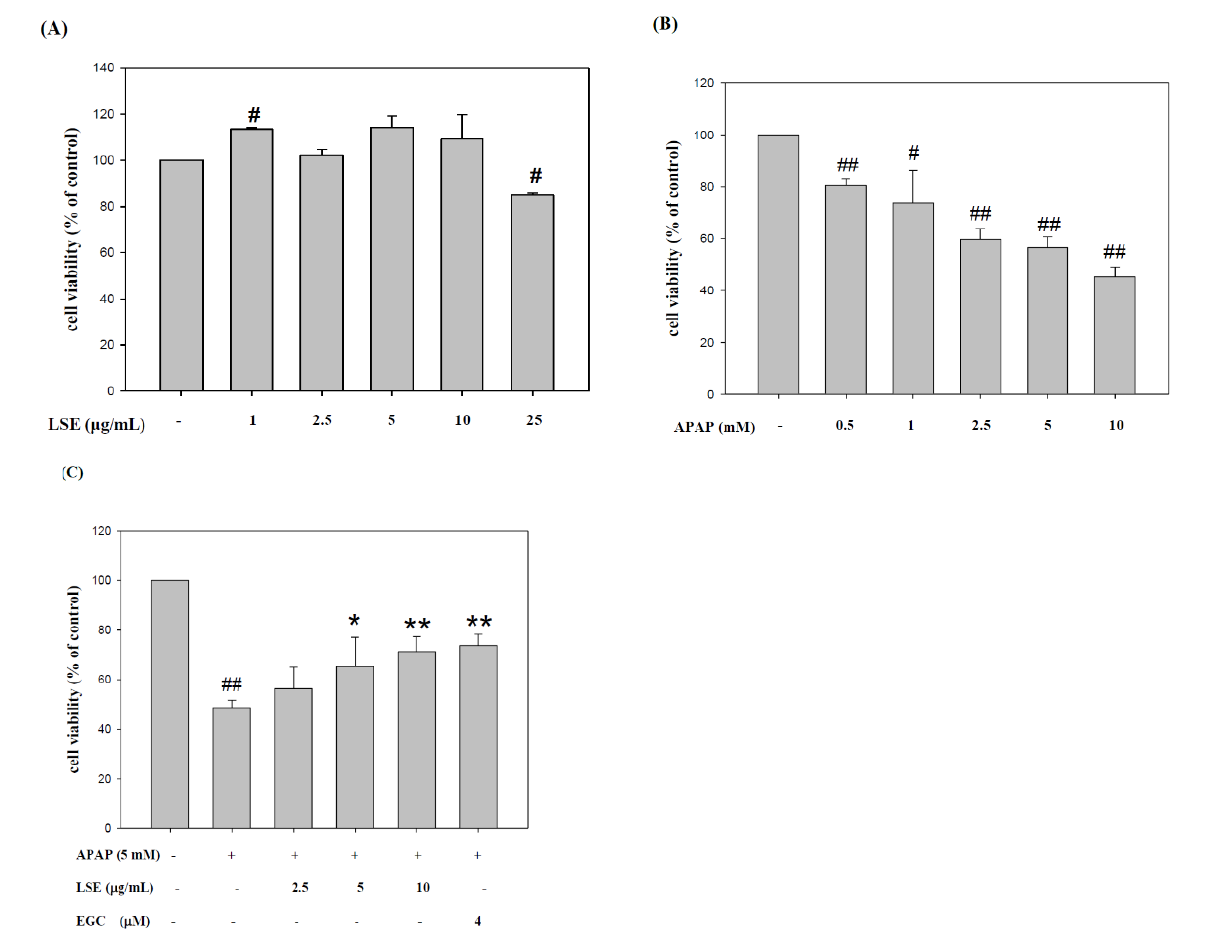
Figure 1. LSE or EGC co-treated with toxic dose of APAP elevated HepG2 cell survival rate. First, the cytotoxic effects of ( A ) LSE and ( B ) APAP in various concentrations on HepG2 cells were evaluated. ( C ) The HepG2 cell viability of APAP in 5 mM with/without LSE in 2.5, 5, and 10 µg/mL or 4 µM EGC. All data are presented as means ± SD of three independent experiments. # p < 0.05, ## p < 0.01 compared with the control group. * p < 0.05, ** p < 0.01 compared with the APAP group. 2.2. LSE Reduced Intracellular ROS Level and Apoptosis Rate in Toxic APAP